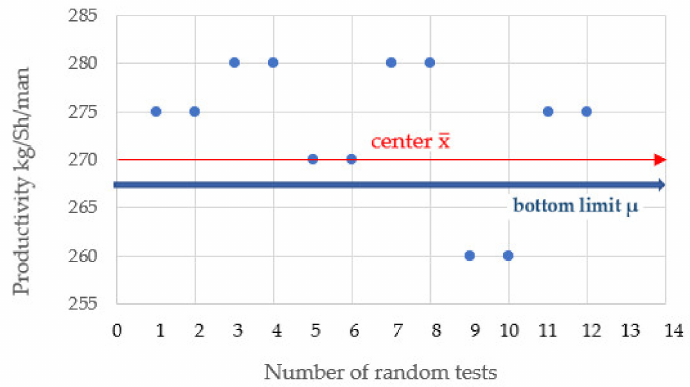
Figure 8. Graphic illustration of iron work performances including the mean